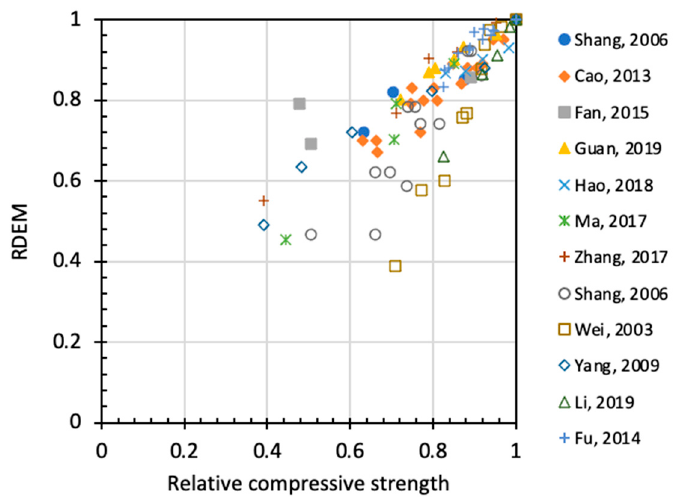
Figure 7. Relation between RDEM and relative compressive strength for non-air entrained concrete.